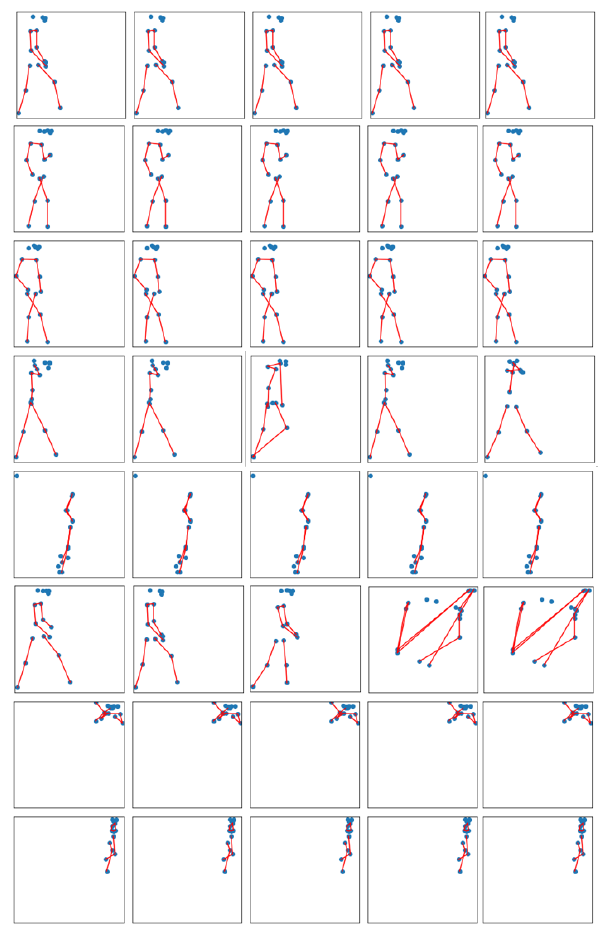
Figure 10. Selected generated poses for Class